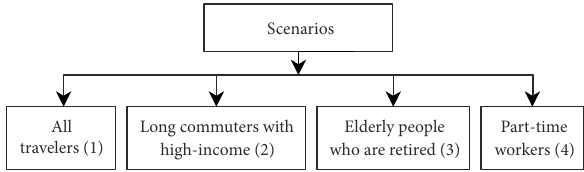
Figure 1. The proposed travellers’ behaviour simulation scenarios